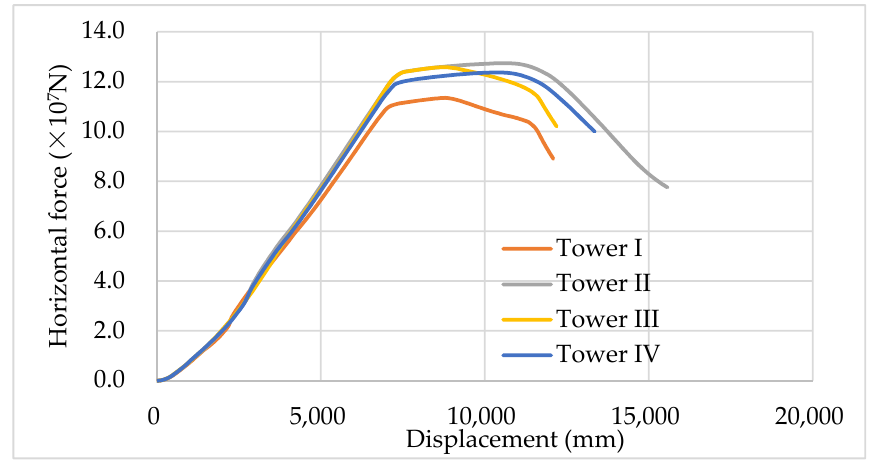
Figure 19. Horizontal force versus displacement with regard to Towers I, II, III, IV.